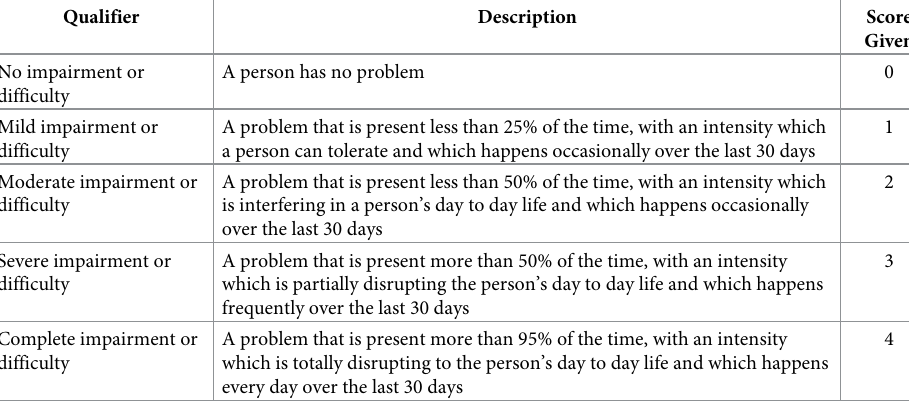
Table 1. Description of